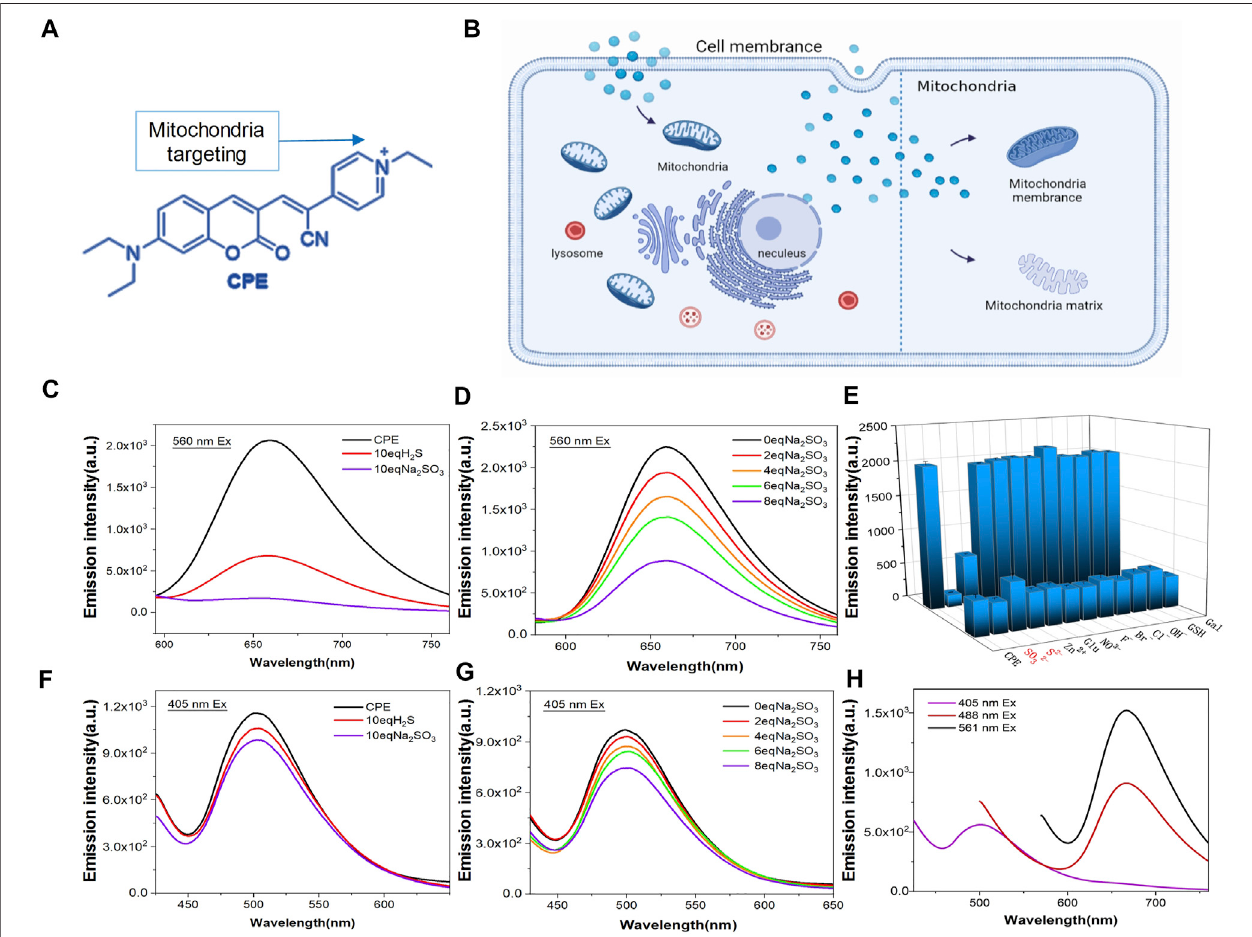
FIGURE1| Designand fl uorescencecharacterizationofCPE. (A) ChemicalstructureofCPE. (B) StainingorganellesofCPE. (E) ResponsivesubstanceofCPE. (H) CPEemissionspectrogram. (C,F) FluorescencespectradeterminedwithH 2 SandNa 2 SO 3 treatments. (D,G) Fluorescencespectraweredeterminedafterresponsewith different concentrations of Na 2 SO 3